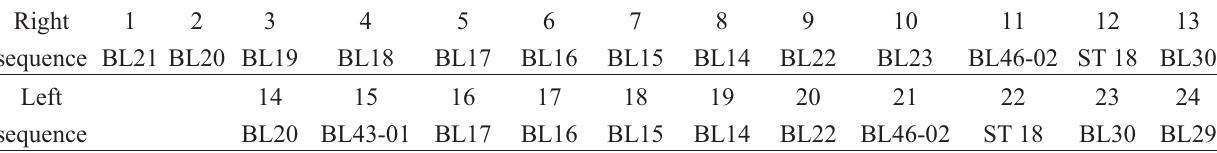
Table 1. The sequence of measurement and the 24 APs, with codes according to IVAS [8]. Right